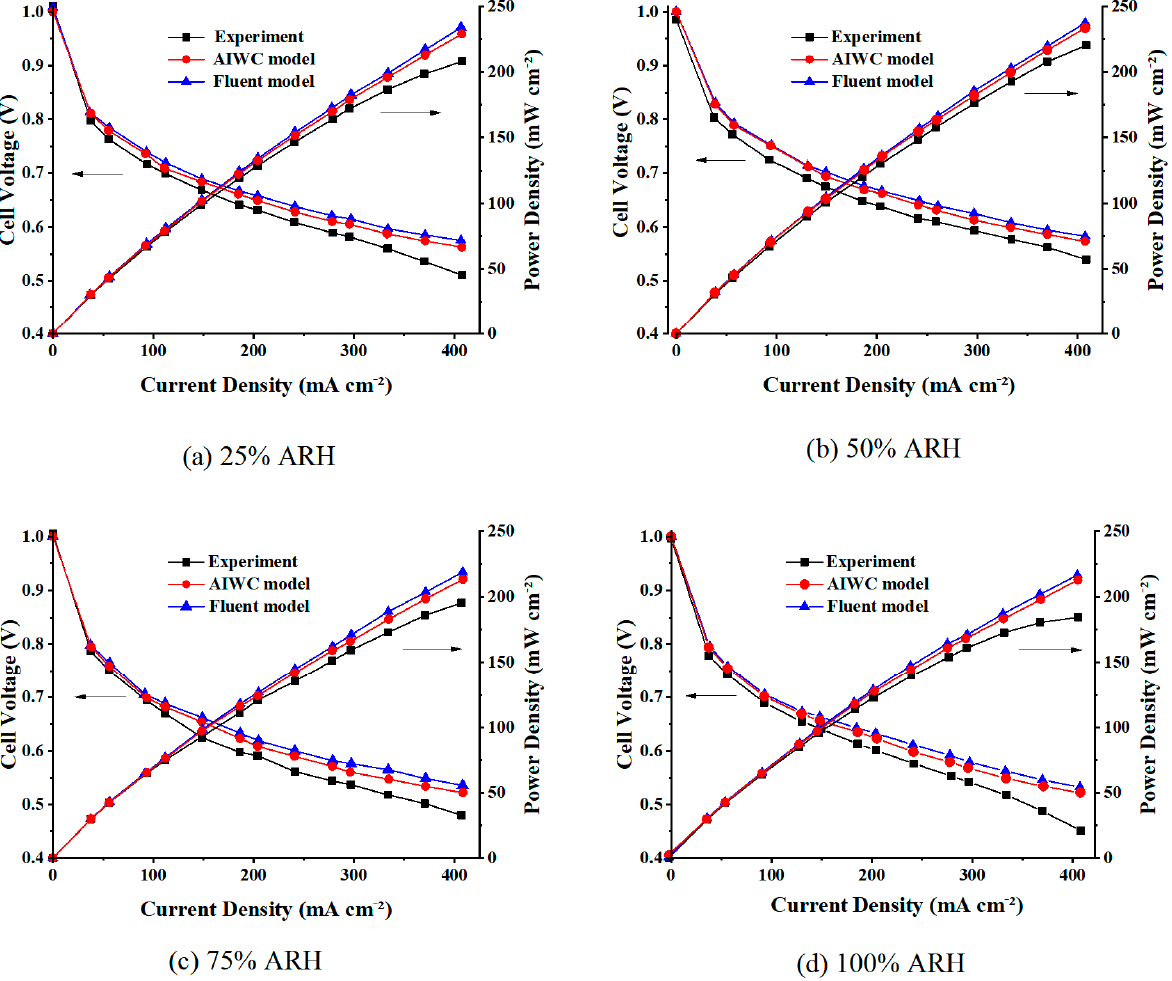
Figure 4. Curves of volt–ampere characteristics.